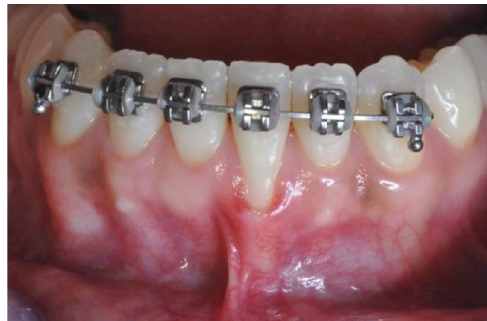
Figure 1: Intrabuccal images before removal of the orthodontic appliance.